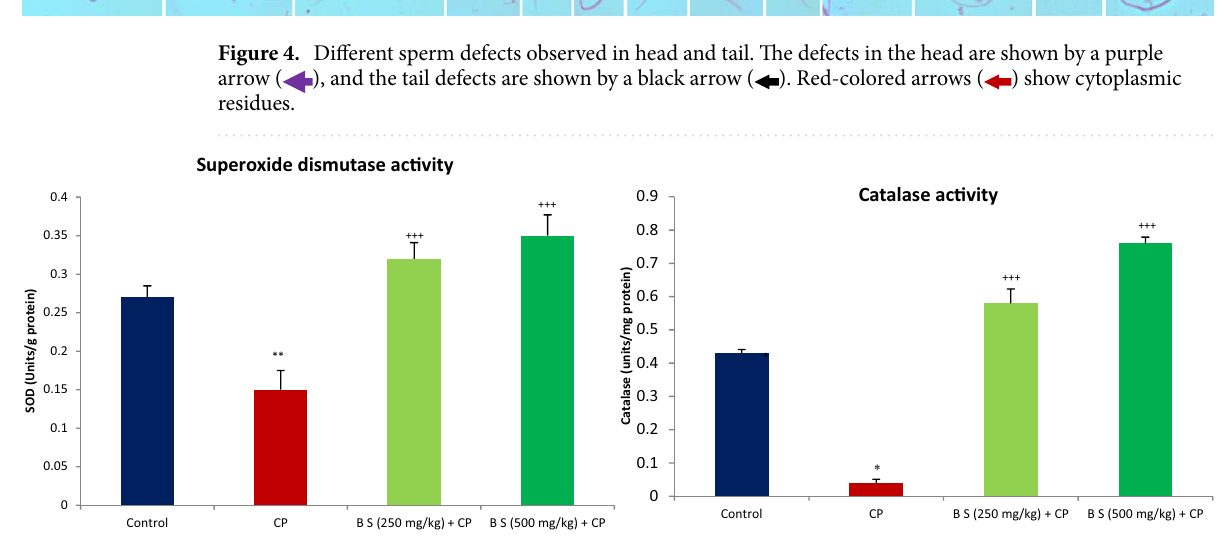
Figure 5. Effect on antioxidant enzymes. All values are mean ± SEM, n = 6. * P < 0.05, ** P < 0.01, compared to control. +++ P < 0.001 compared to CP treated group CP = Cyclophosphamide (200 mg/kg, i.p), B S Boswellia sacra